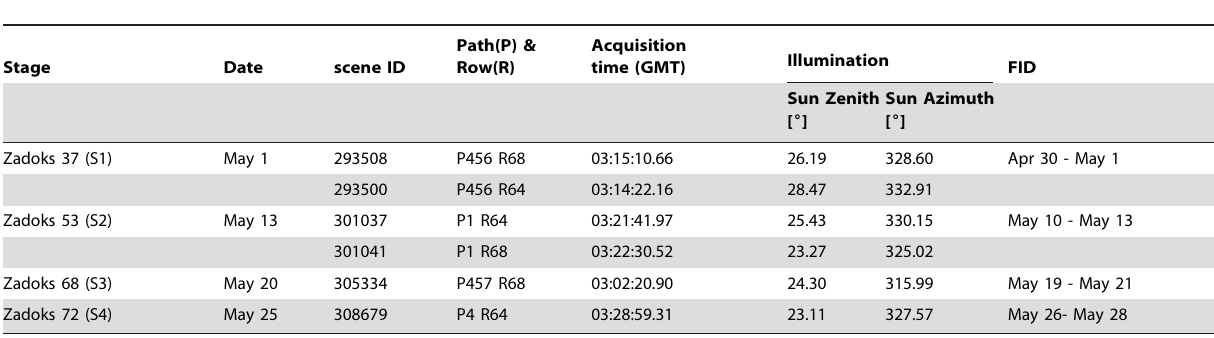
Table 1. Detailed information of acquired scenes and corresponding field